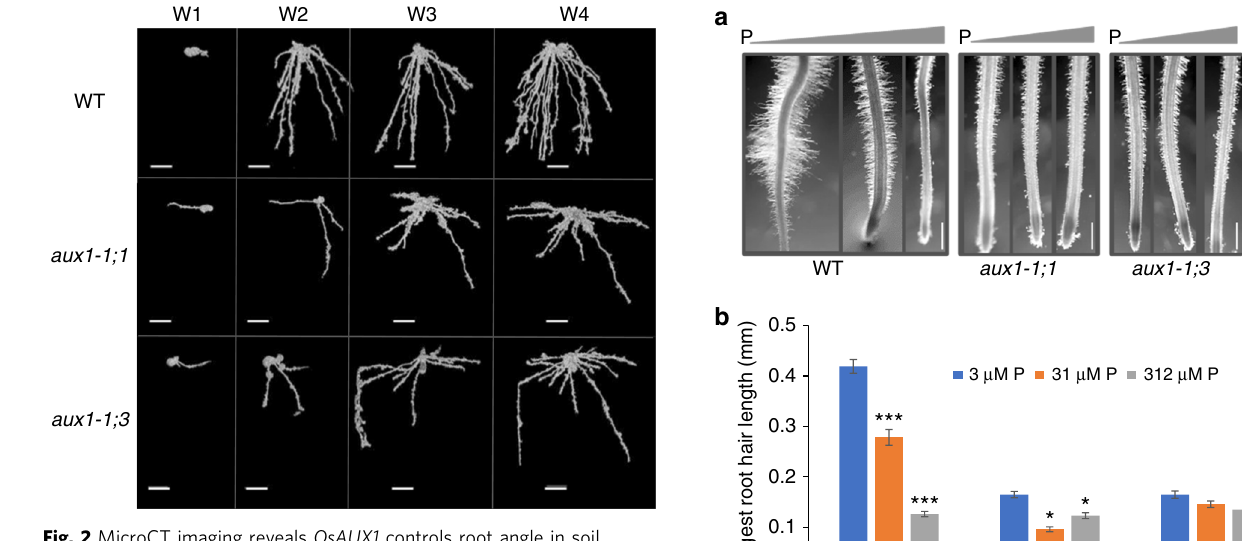
Fig. 2 MicroCT imaging reveals OsAUX1 controls root angle in soil. Comparison of root angles from X-ray CT images of soil grown wild-type (WT), osaux1-1;1 and osaux1-1;3 roots at 1-, 2-, 3-, and 4-week-old stages (denoted W1 – 4). Scale bar represents 2 cm